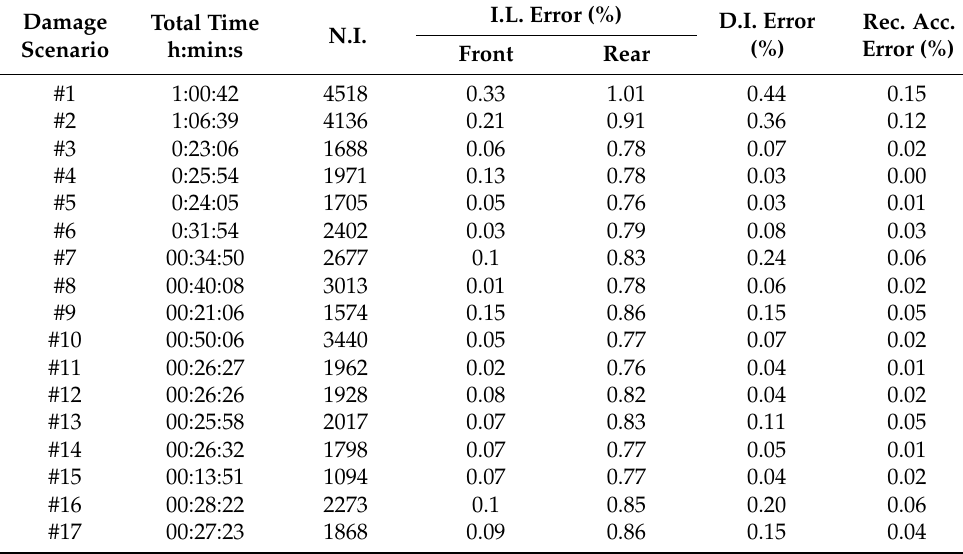
Table 4. The results obtained from different damage